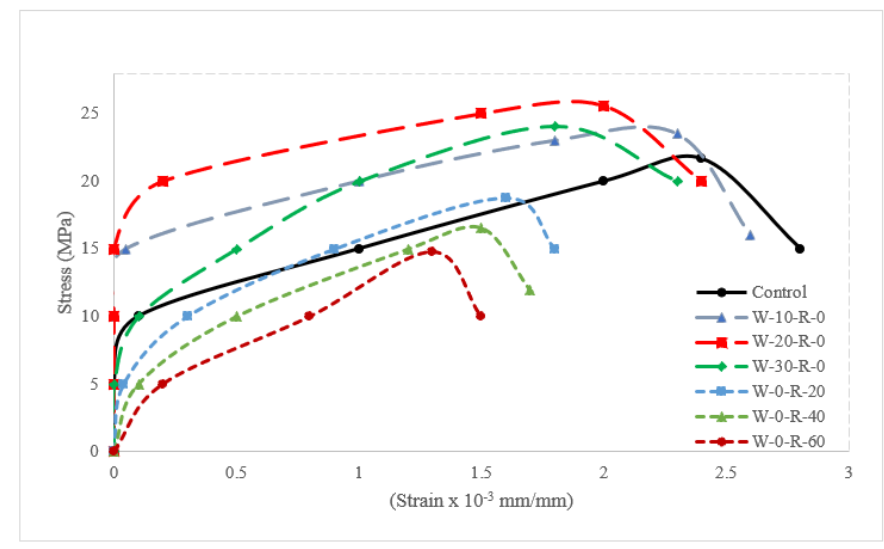
Figure 15. Stress-strain curve of various doses of waste glass and